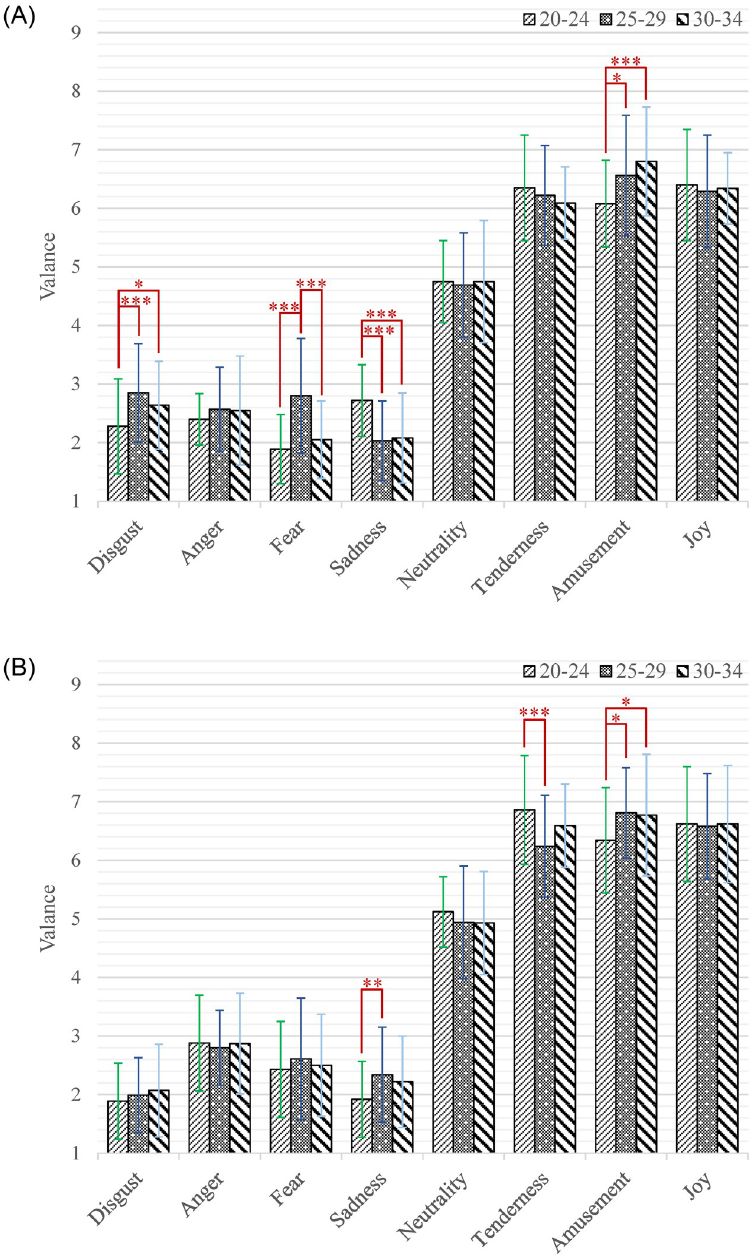
Fig 3. The valence scores of each category of emotion-inducing short videos among participants with different ages. A: Male. B: Female. Statistical significance: * p < 0.05, ** p < 0.01, *** p < 0.001. Unless marked with the asterisk, no significant differences between these groups were